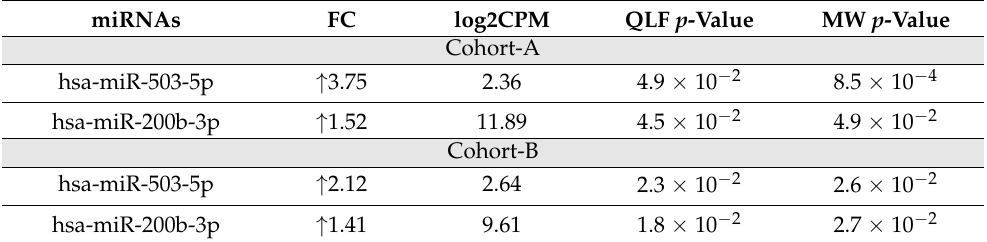
Table 1. Upregulated miRNAs in unfavorable prognosis group.